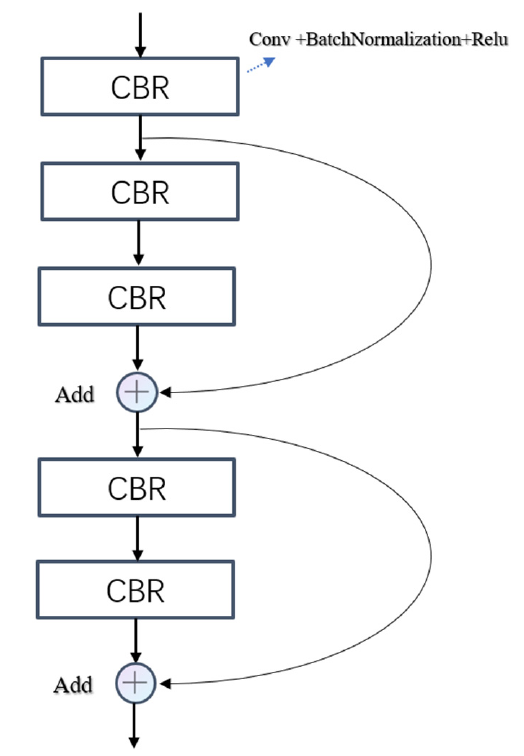
Figure 5. The structure of Res-Block. CBR represents convolution + batchnomlization + relu. In the overall MFCD-Net, the PFE module is used to extract the polarization features of polarization images Q and U at different levels. In the BFEF module, we fuse these polarization features using the CA module at different scales with the spatial-angle-spectral features extracted from the reflectance images. Next, we decode these fused high-level features in the up-sampling module. Finally, the fused features are output as cloud masks through the detection module. These modules are discussed as